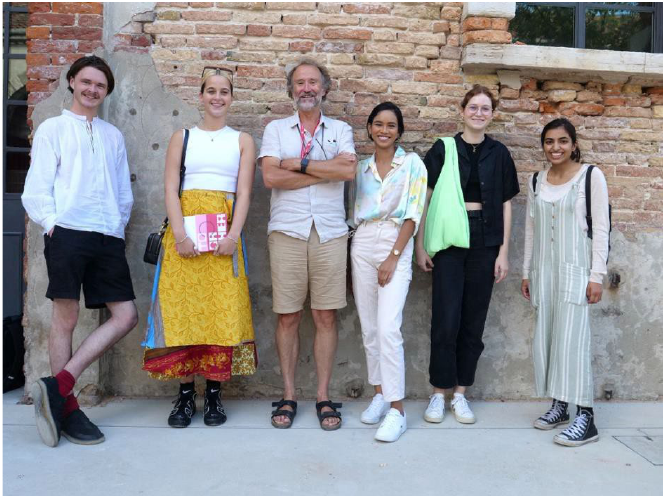
Figure 1 Venice participants at the start of the workshop (from L to R: Reuben, Angel, François, Shireen, Karolina, Sumaiyah)